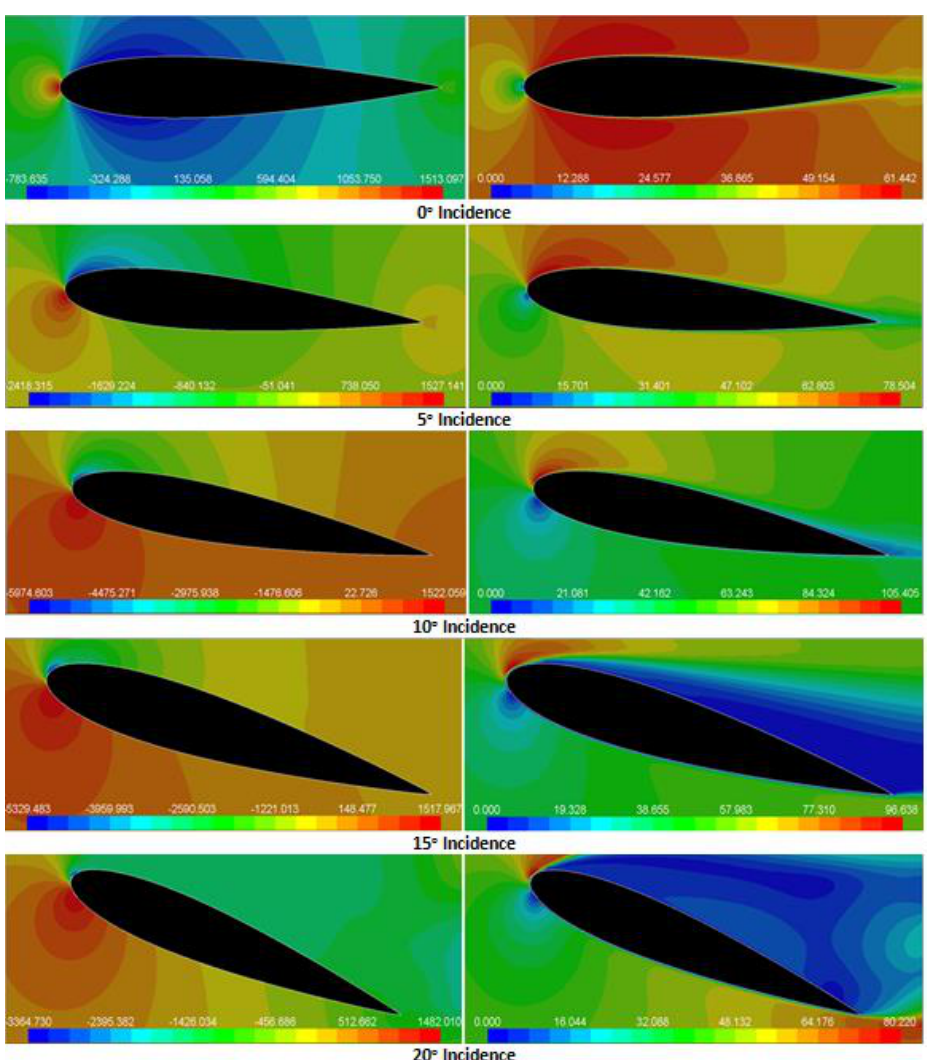
Figure 6. Static pressure and velocity magnitude contours around the NACA 0015 airfoil at different incidence angles.